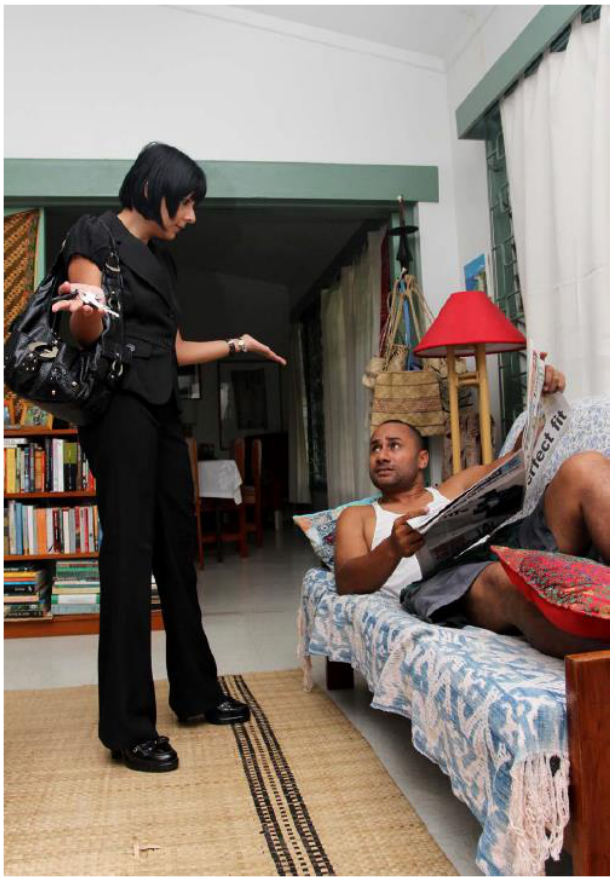
SCENARIO 9: Women’s paid labour outside the home; men’s labour inside the home